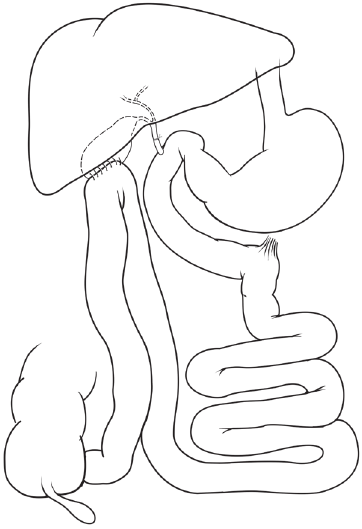
Figure 6. Bile diversion. In the absence of any gastric restriction, the common bile duct is ligated proximal to the pancreatic duct and an anastomosis is created between a portion of ileum and the gallbladder. Pancreatic secretions follow their normal course and drain into the duodenum, but biliary secretions are diverted to the portion of ileum connected directly to the